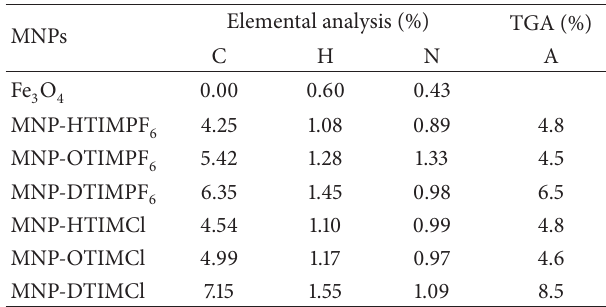
Table 1: Ionic liquids synthesized for this study. Table 2: Results of elemental analysis and TGA of